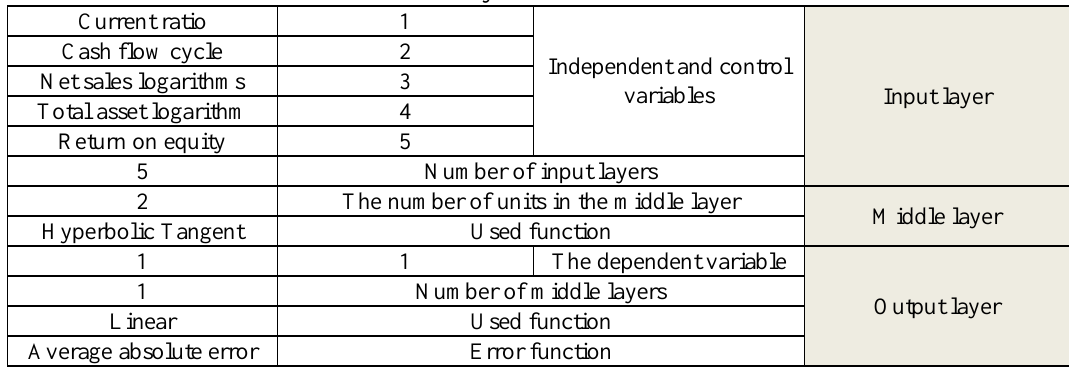
Table 6. Summary of Neural Network